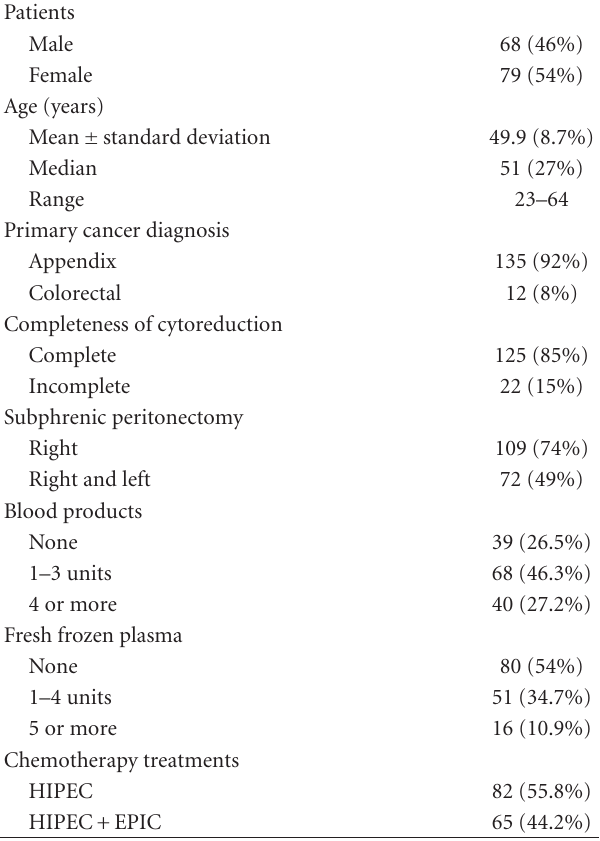
Table 2: Demographic and clinical